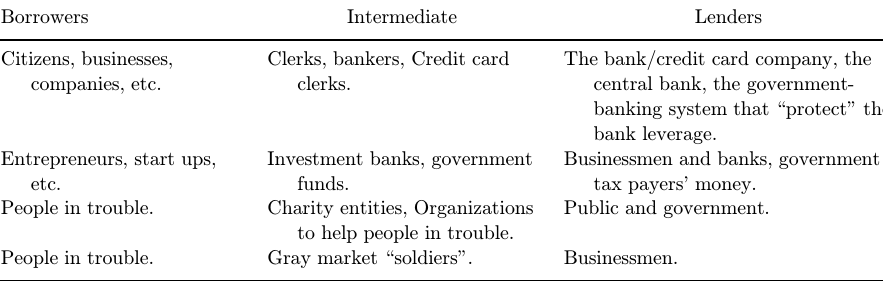
Table 1. The parties of the funding world. Borrowers Intermediate